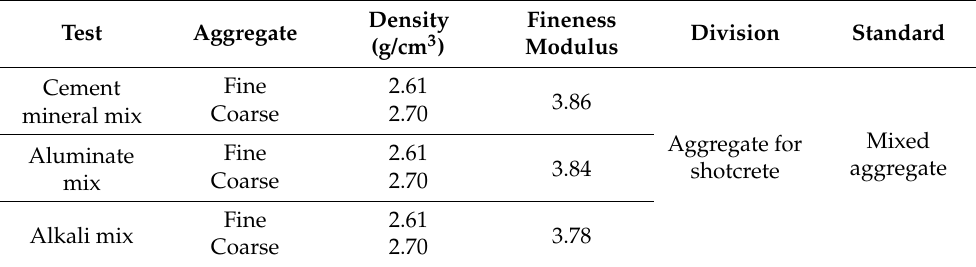
Table 1. Physical properties of fine and coarse